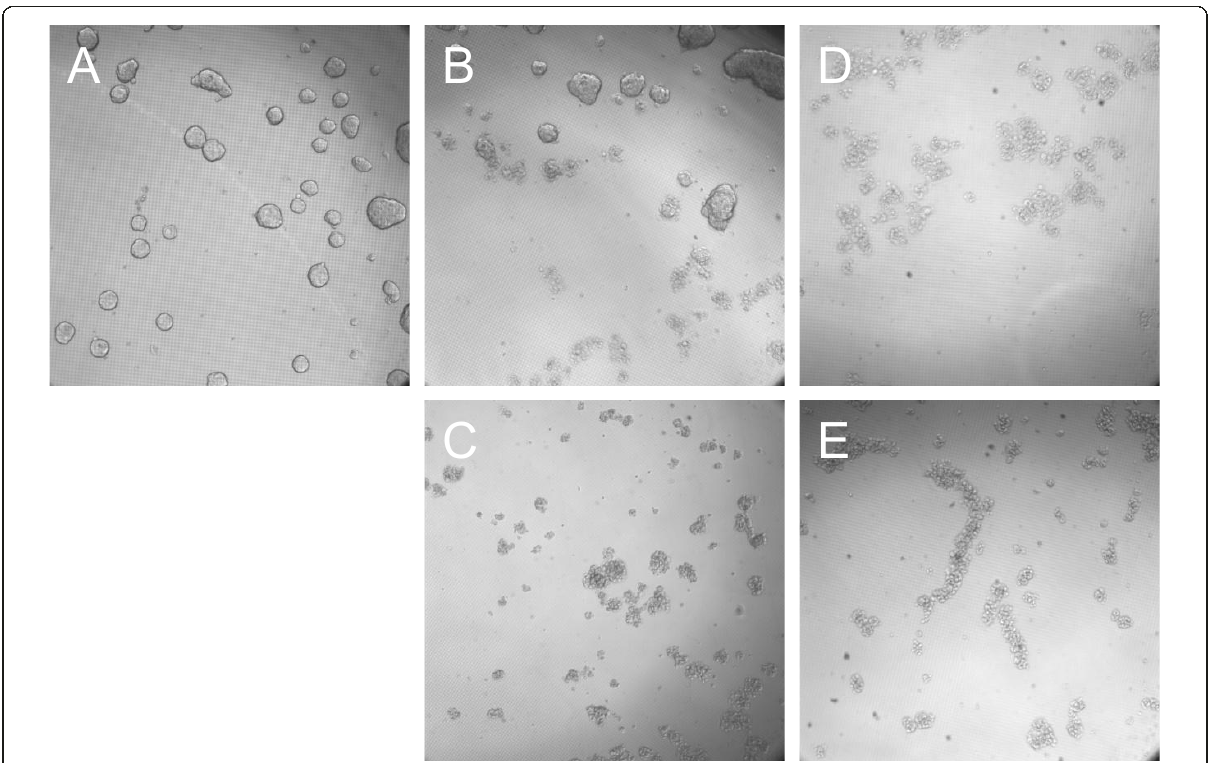
Figure 6 Capability of Boswellia sacra essential oil in suppressing multicellular spheroid growth . Breast cancer T47 cells (1 × 10 4 ) were seeded into each well of the 96-well NanoCulture ® plates. Following the formation of spheroids, cells were either (A) left untreated or treated with 78 o C essential oil at (B) 1:800 or (C) 1:600 dilution, or 100 o C essential oil at (D) 1:1,500 or (E) 1:1,200 dilution. Spheroids images